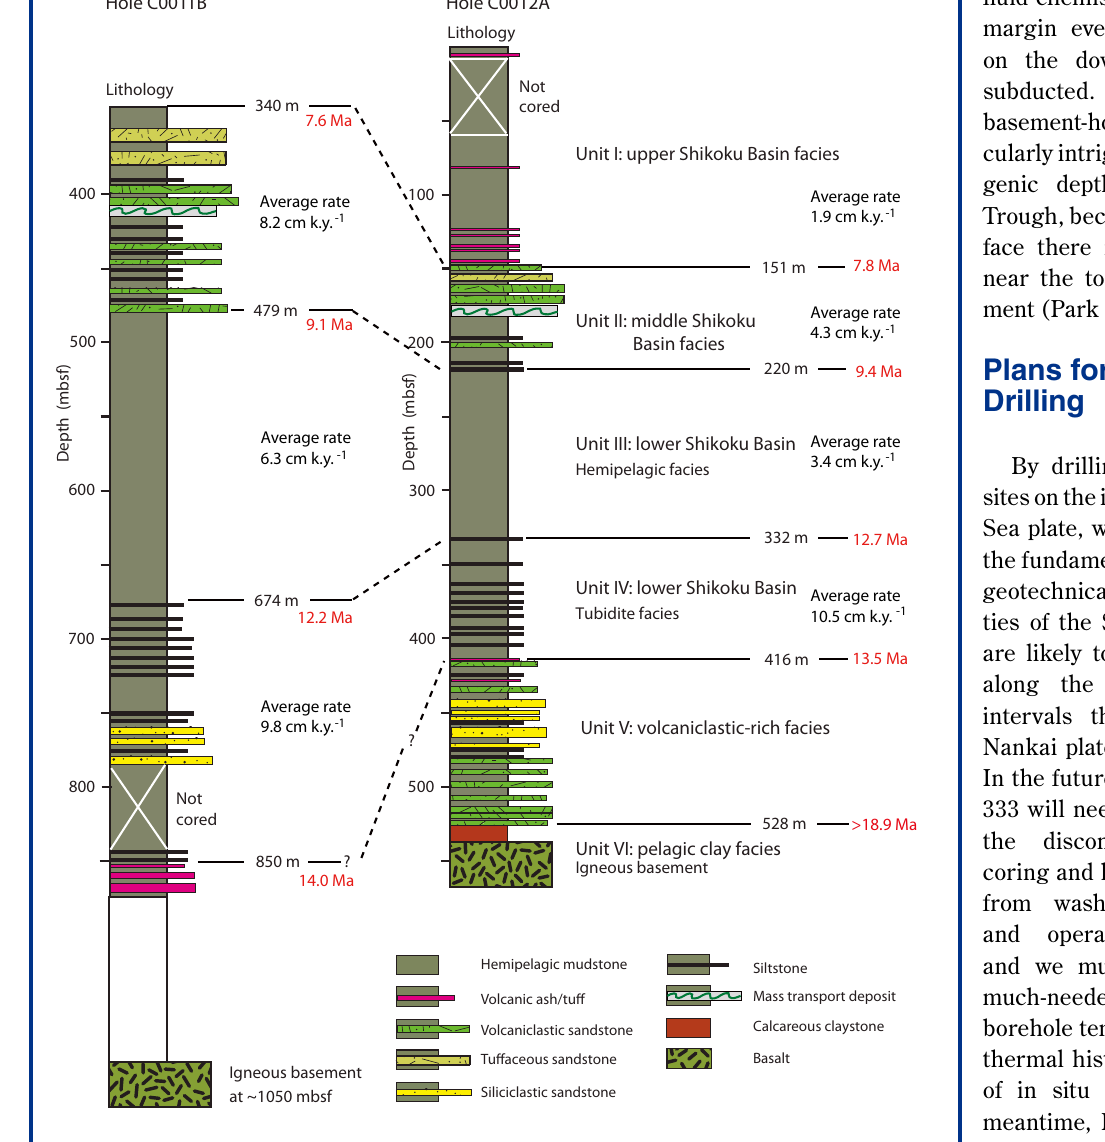
Figure 8. Stratigraphic correlation between Sites C0011 and C0012. For Site C0011, logging-while-drilling data only from 0 mbsf to 340 mbsf. Unit boundary ages taken from integrated age-depth models (biostratigraphy and